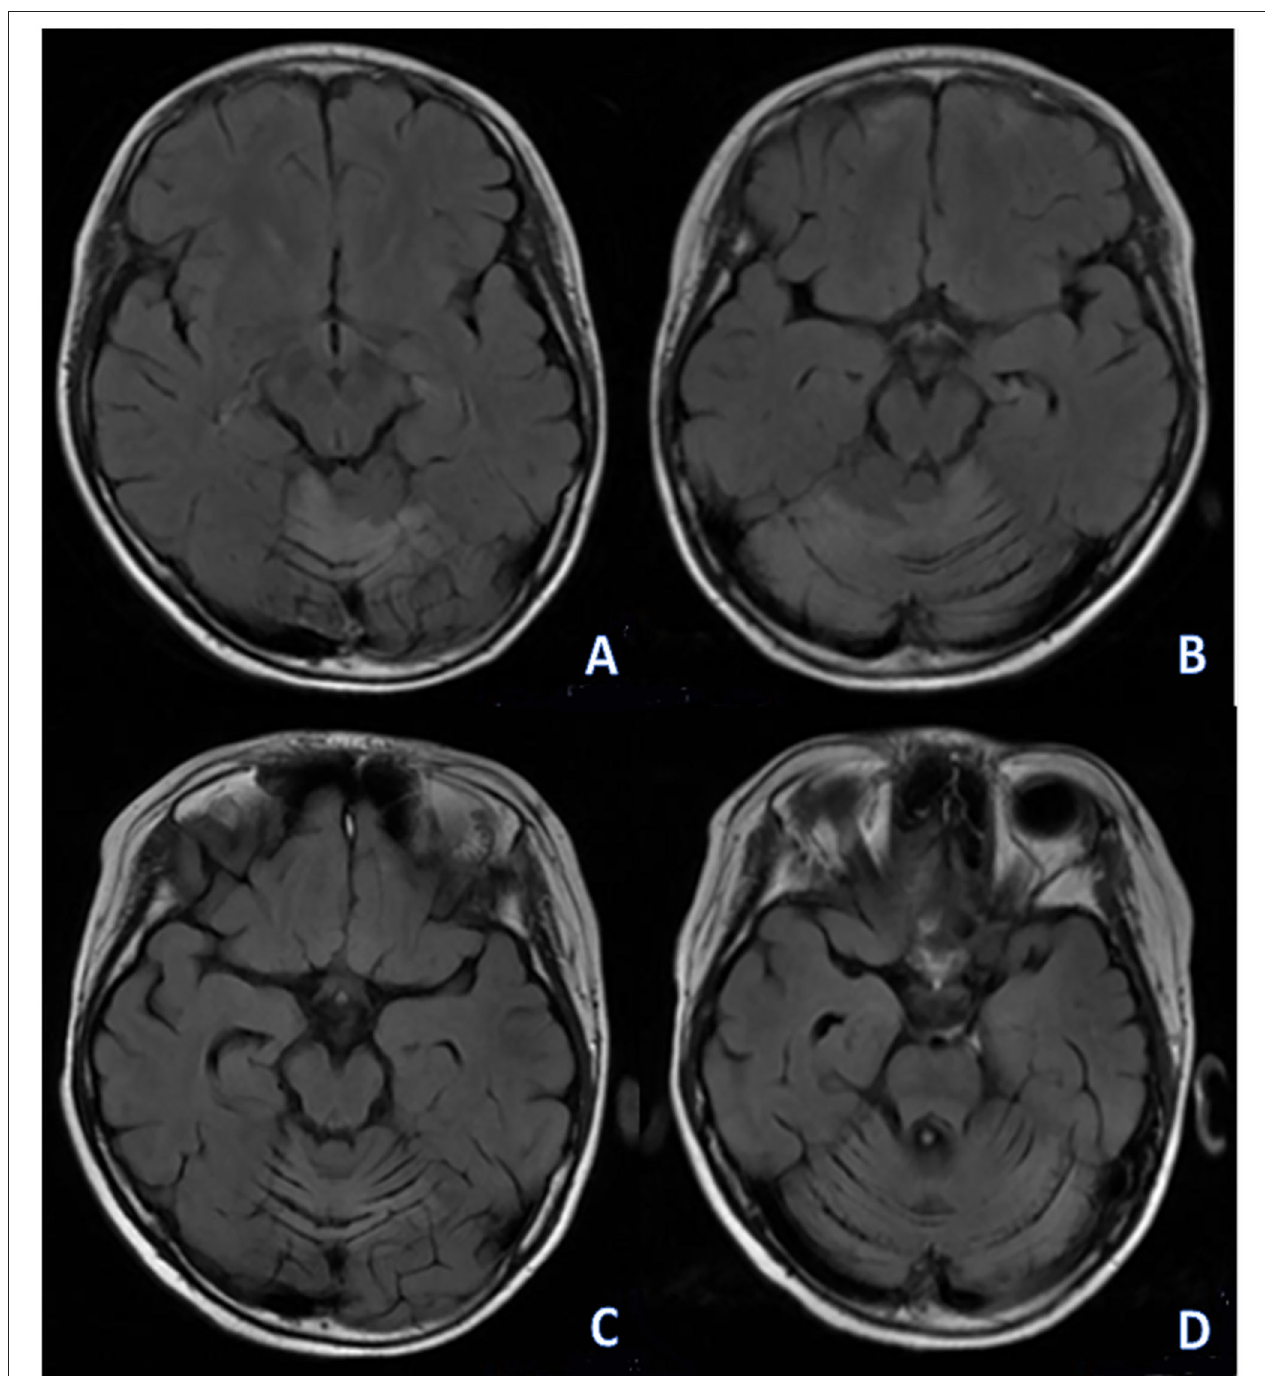
FIGURE 2 | (A,B) initial MRI: right cerebellar atrophy and multiple lesions in bilateral cerebellum and vermis. (C,D) follow-up MRI showed bilateral cerebellum and vermis atrophy, sulcus of left cerebellum was wider.